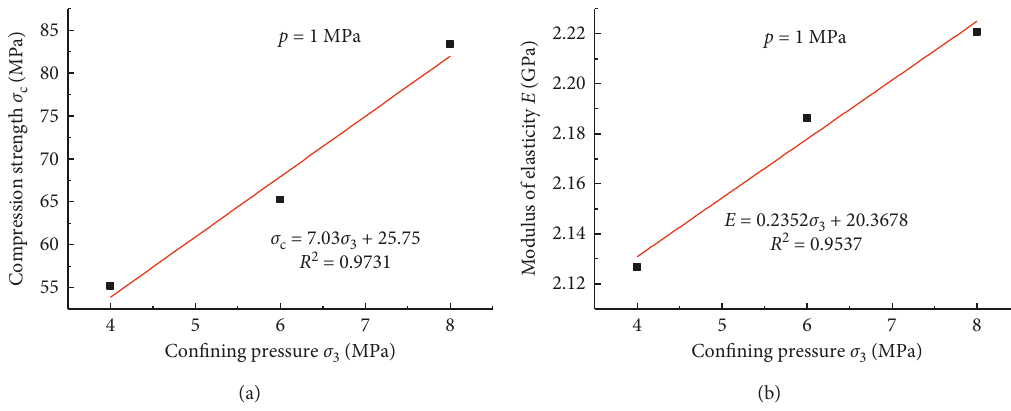
Figure 5: Variations of (a) compression strength and (b) modulus of elasticity with confining pressure.